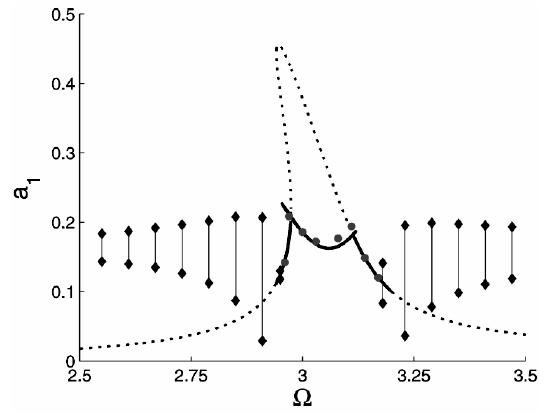
Fig. 10. Analytical and numerical results for the NSC controller. An- alytical solution: solid line – stable solutions, dotted line – unstable solutions. Numerical results: circles – amplitude of periodic motion, diamonds – maximum and minimum amplitude of positive part of en-